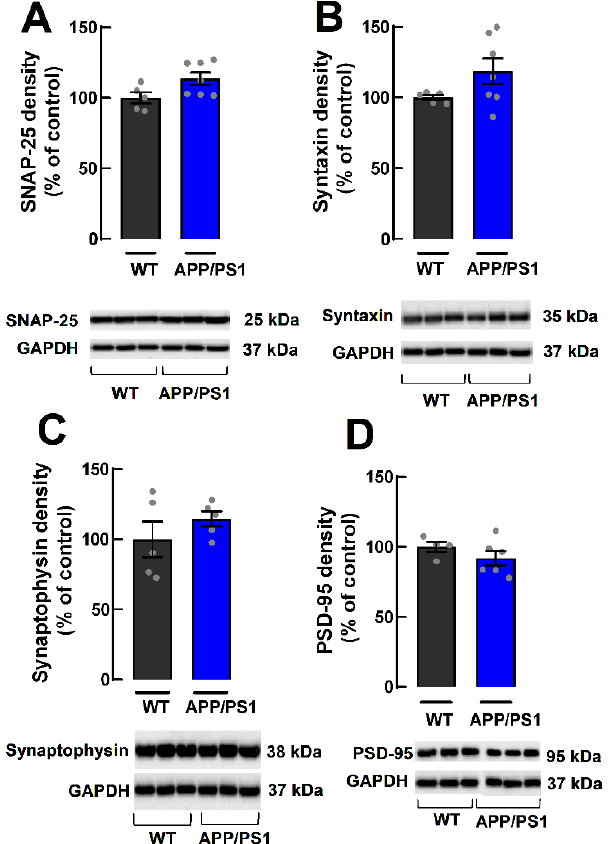
Figure 4. Relative density of synaptic markers in cerebrocortical synaptosomes of 9-month-old female WT and APP/PS1 mice. There were no significant differences in the density of the synaptic proteins evaluated, as shown in ( A ) SNAP-25, ( B ) syntaxin, ( C ) synaptophysin and ( D ) PSD-95. Data are mean ± SEM of 4–7 experiments (number of di ff erent animals tested).